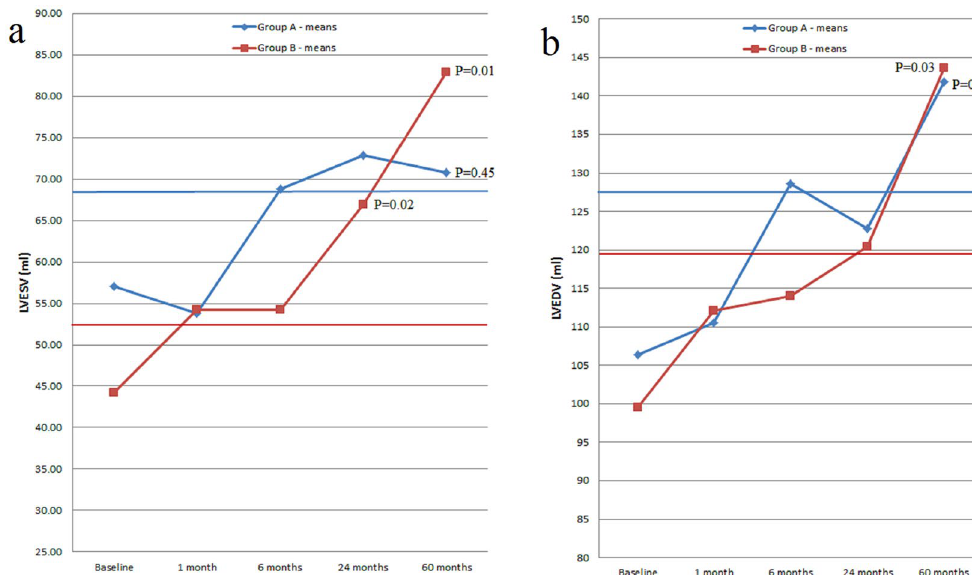
Figure 7. Left ventricular end-systolic volume (Panel a) and left ventricular end-diastolic volume (Panel b) progression in the two groups, from baseline to 60 months follow-up, with left ventricular remodelling criteria. Horizontal blue line − 20% increase limit in Group A; horizontal red line − 20% increase limit in Group B; LVESV = left ventricular end-systolic; LVEDV = left ventricular end-diastolic